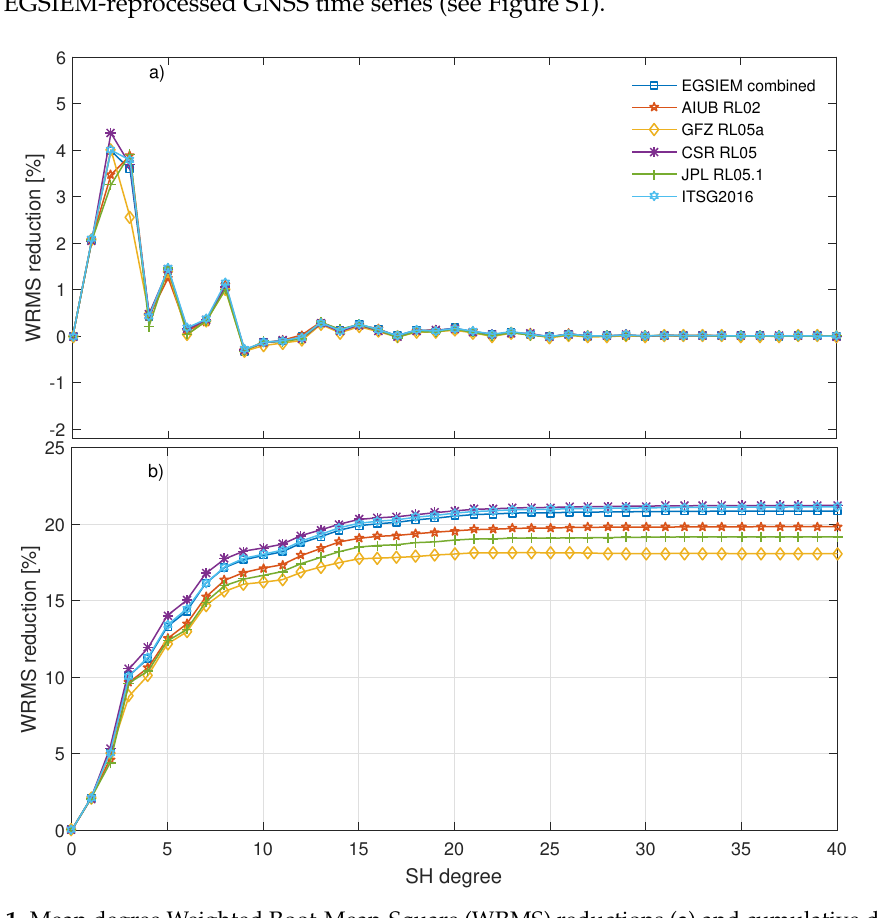
Figure 1. Mean degree Weighted Root-Mean-Square (WRMS) reductions ( a ) and cumulative degree WRMS reductions ( b ) of different gravity solutions using the ITRF2014 residuals over 928 Global Navigation Satellite System (GNSS) stations globally. We truncate the horizontal axis at degree 40 as curves become nearly flat beyond degree